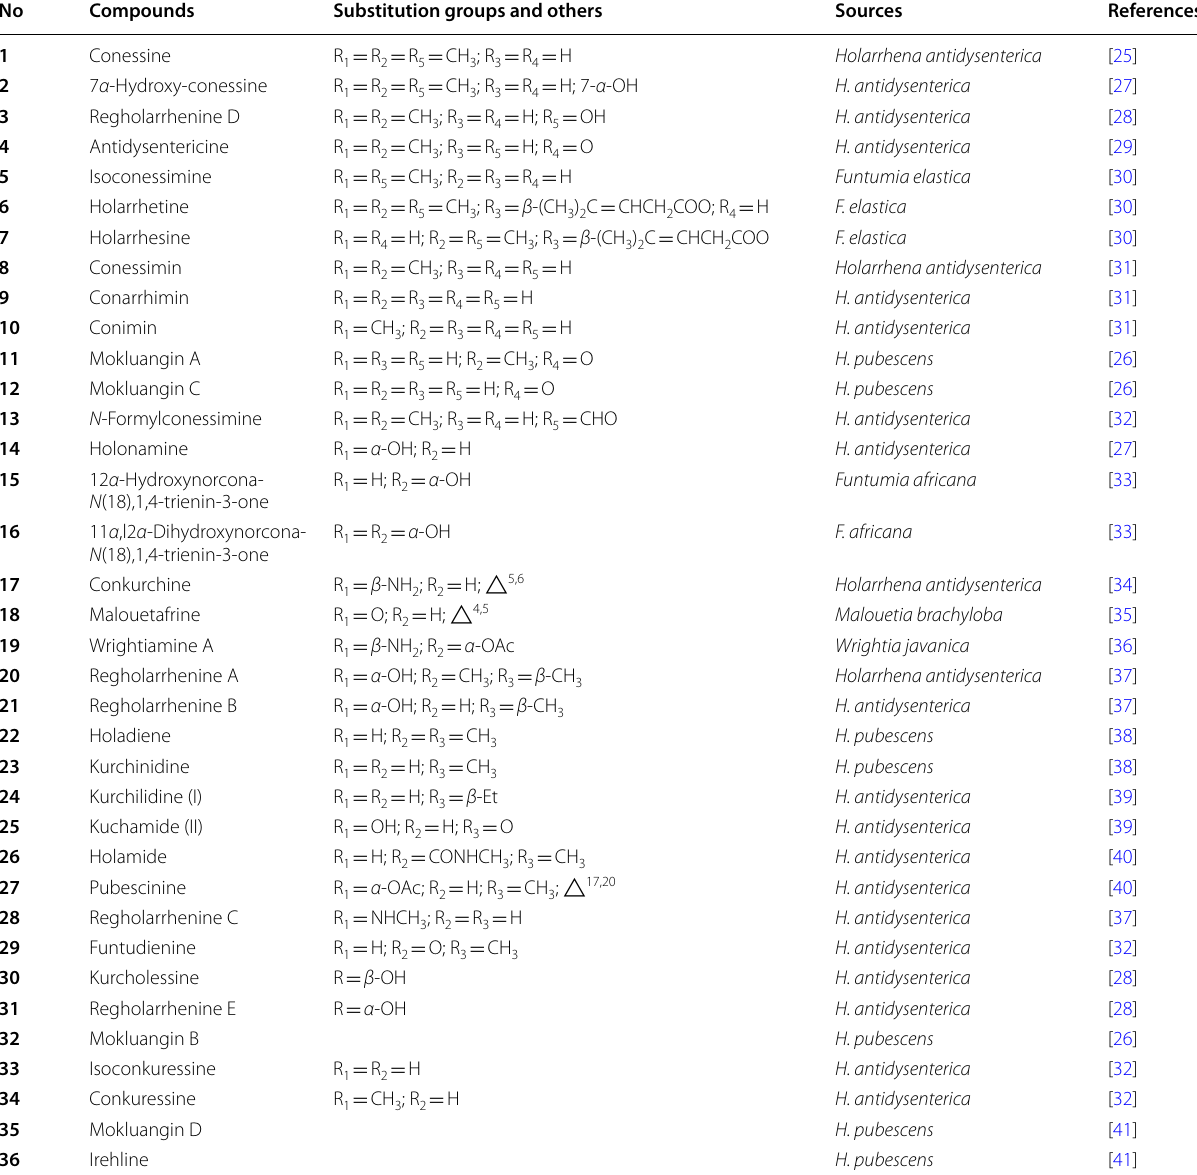
Table 1 Structures and sources of conanine type steroidal alkaloids 1–36 No